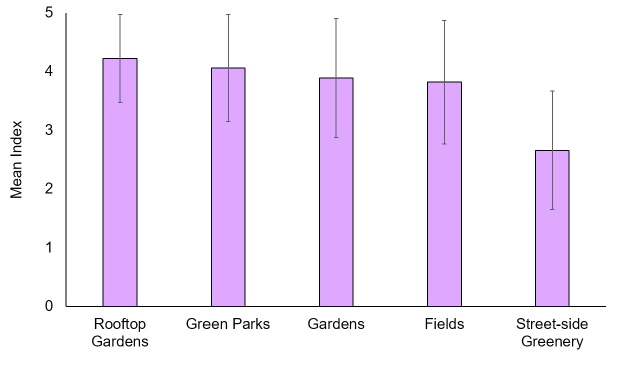
Fig. 4 . Importance of green spaces for providing CES. Criteria of Assessment for mean index: 1 = Not important, 2 = Slightly important, 3 = Moderately important, 4 = Important, 5 = Very important. Error bars represent Standard